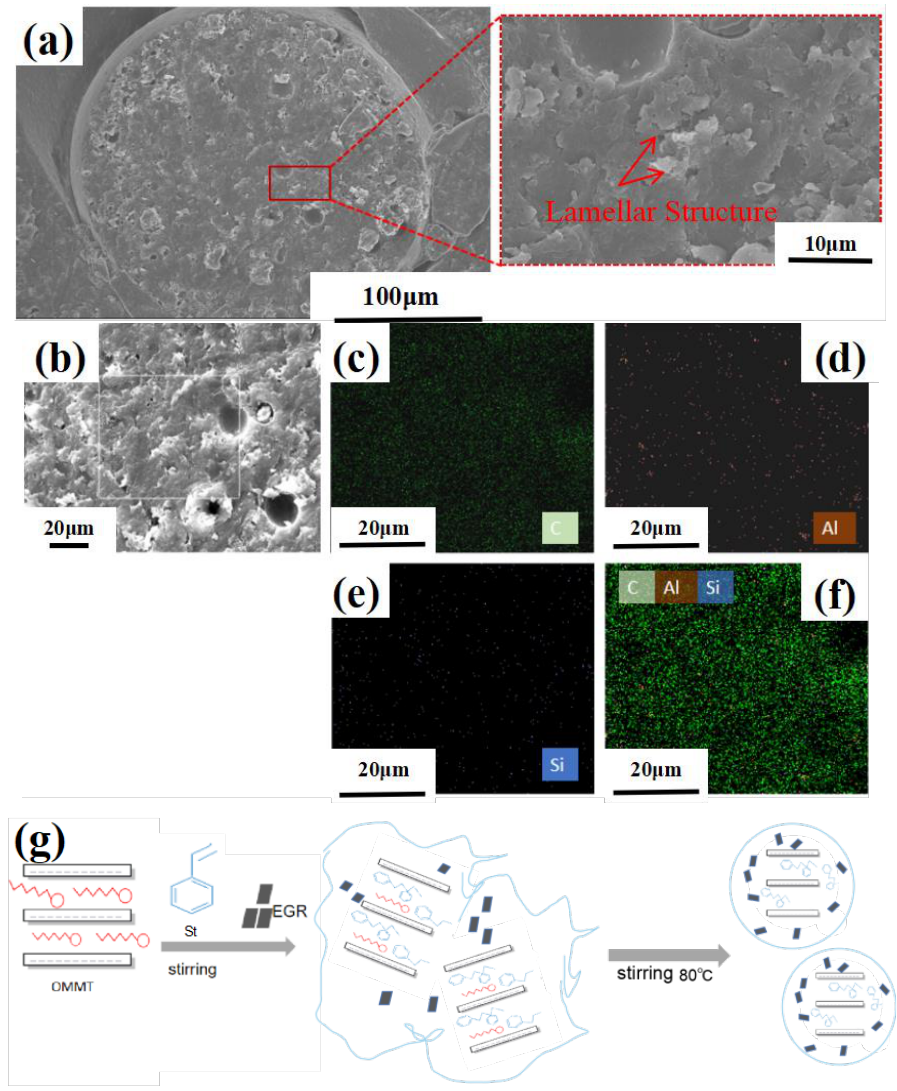
Figure 4. ( a ) SEM image of OMMT/EGR/PS after acetone corrosion and ( b – f ) distribution image of its EDS elements; ( g ) schematic of OMMT/EGR/PS polymerization process.